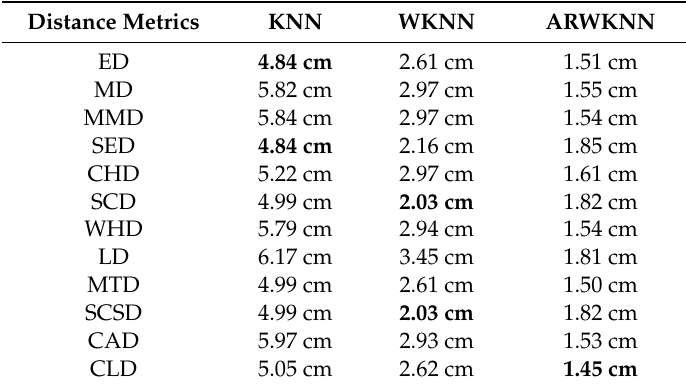
Table 4. In 2-D, the impact of distance metrics on the average positioning error with K max = 4, best values for KNN, WKNN, and ARWKNN algorithms are highlighted in bold.